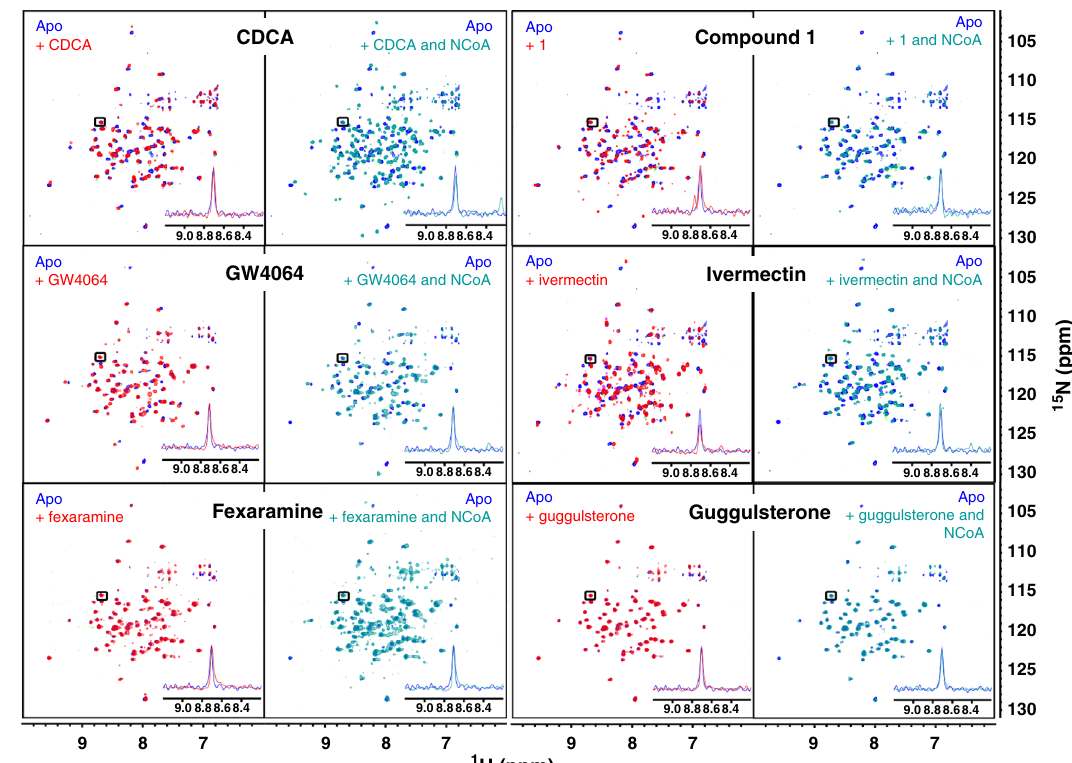
Fig. 4 1 H/ 15 N-HSQC spectra of fully labeled FXR-LBD. Left panels show superposition of apo and apo + ligand, right panels show superposition of apo and apo + ligand + co-activator peptide. Blue — apo; red — with ligand; cyan — with ligand and co-activator peptide (NCoA). Concentrations of protein (200 µ M), peptide (500 µ M) and ligand (500 µ M) were constant for all experiments to ensure saturation. All spectra were processed and compared at the same S/N. A representative signal is shown in each panel to visualise equal S/N. In unliganded state, the 1 H/ 15 N-HSQC reveals only a fraction of all signals indicating conformational fl exibility of part of the FXR-LBD. Upon addition of an FXR agonist (CDCA, GW4064 or fexaramine), additional but still not all signals appear suggesting partial stabilisation of the protein. Addition of co-activator peptide causes marked further stabilisation as observed by appearance of almost all 1 H/ 15 N-HSQC signals. Addition of the FXR partial agonists ivermectin or 1 also induced stabilisation of the FXR-LBD but in contrast to the